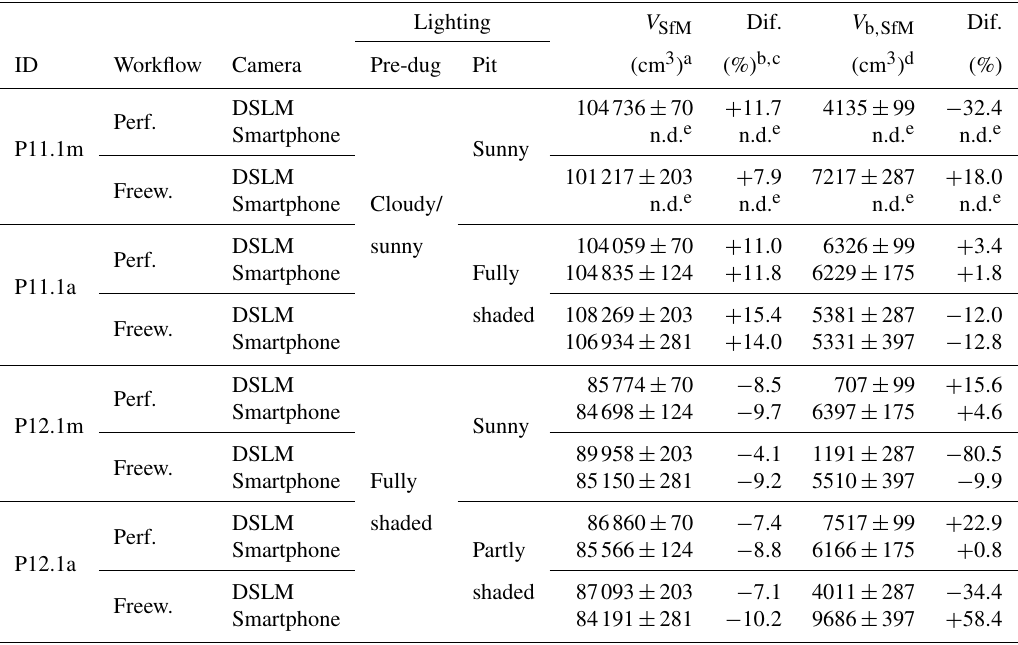
Table 5. Imaging scenarios and SfM-MVS photogrammetry-derived volumes of the modified pits BD17-P11.1 and BD17-P12.1 ( V SfM ) and the resulting boulder volumes ( V b , SfM